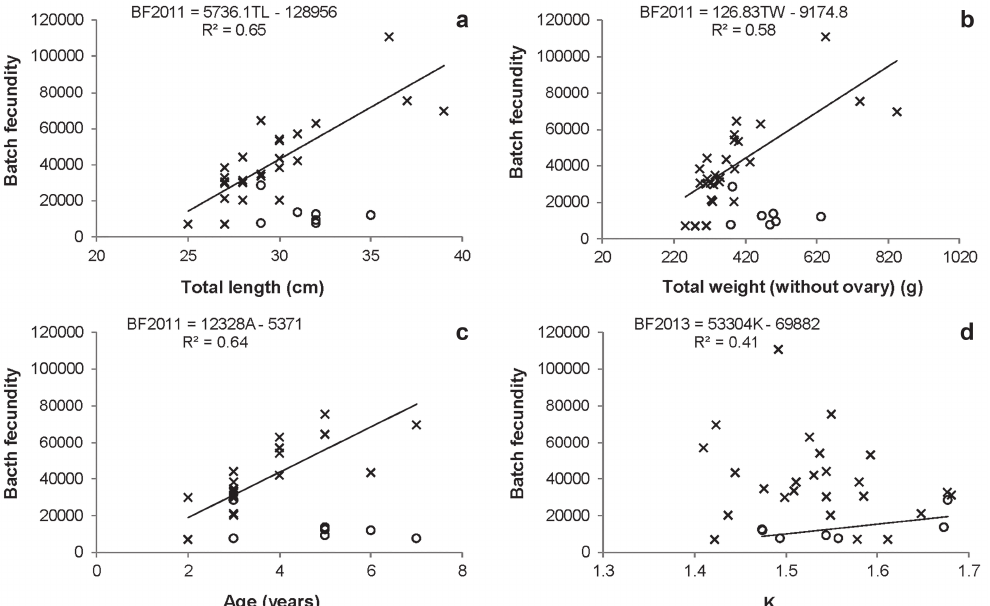
Fig. 4. Relationships of batch fecundity (BF) to: ( a ) total length, ( b ) total weight (without ovary), ( c ) age, and ( d ) condition factor for Pagrus pagrus collected in 2011 (cross) and 2013